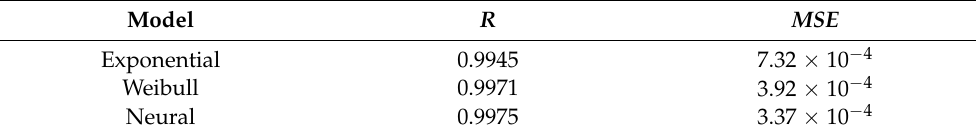
Table 5. Accuracy of models.